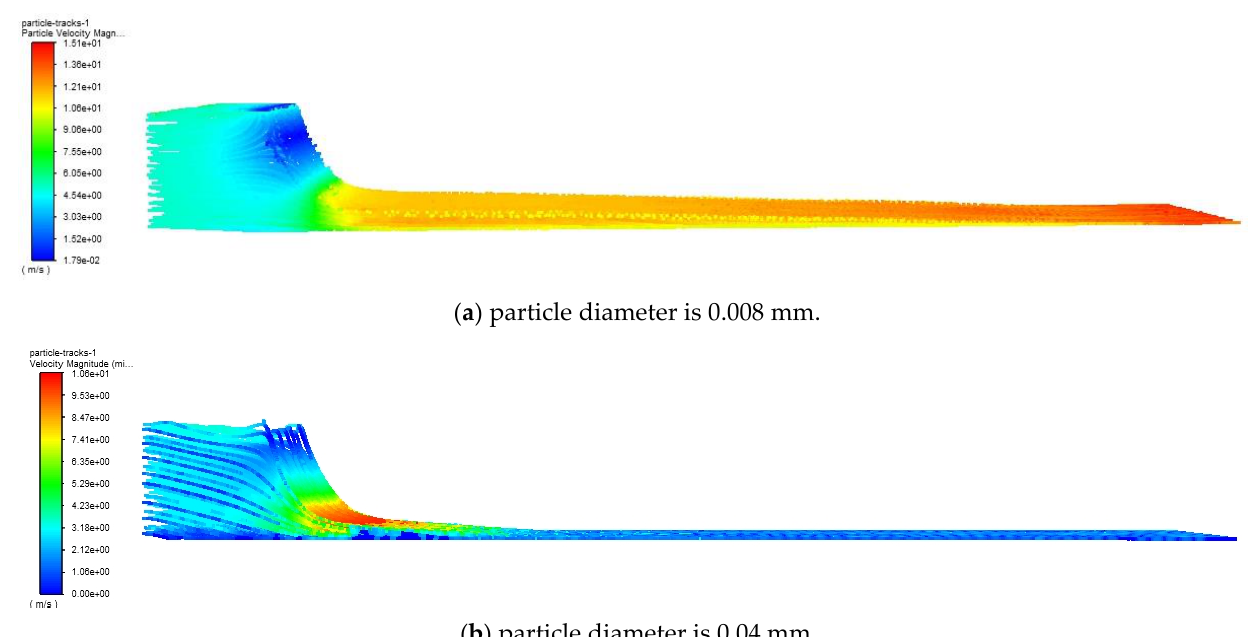
Figure 10. Relationship between erosion and sediment concentration. 3.2.3. Effect of Flow Velocity on Erosion Under the condition of other factors being the same, the influence of the inlet velocity of the spillway on erosion was analyzed. The inlet velocity of the fluid domain is 2 m/s, 3 m/s, 4 m/s, 5 m/s, 6 m/s, 7 m/s and 8 m/s, 9 m/s. The sediment concentration is 3.2 kg/m 3 , the sediment particle size is 0.025 mm, the water depth before setting the spillway is 6.5